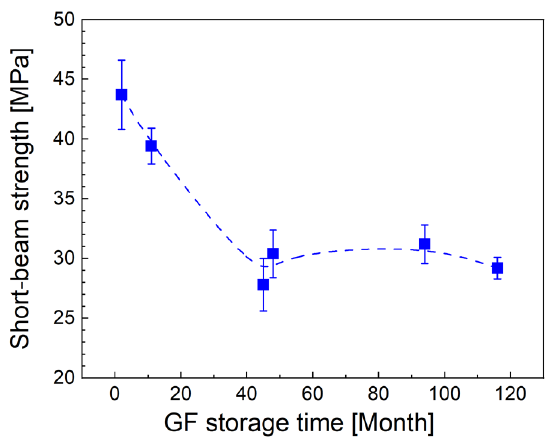
Figure 3. Short-beam strength for GF/polyester composites reinforced with glass fibers with different storage times.